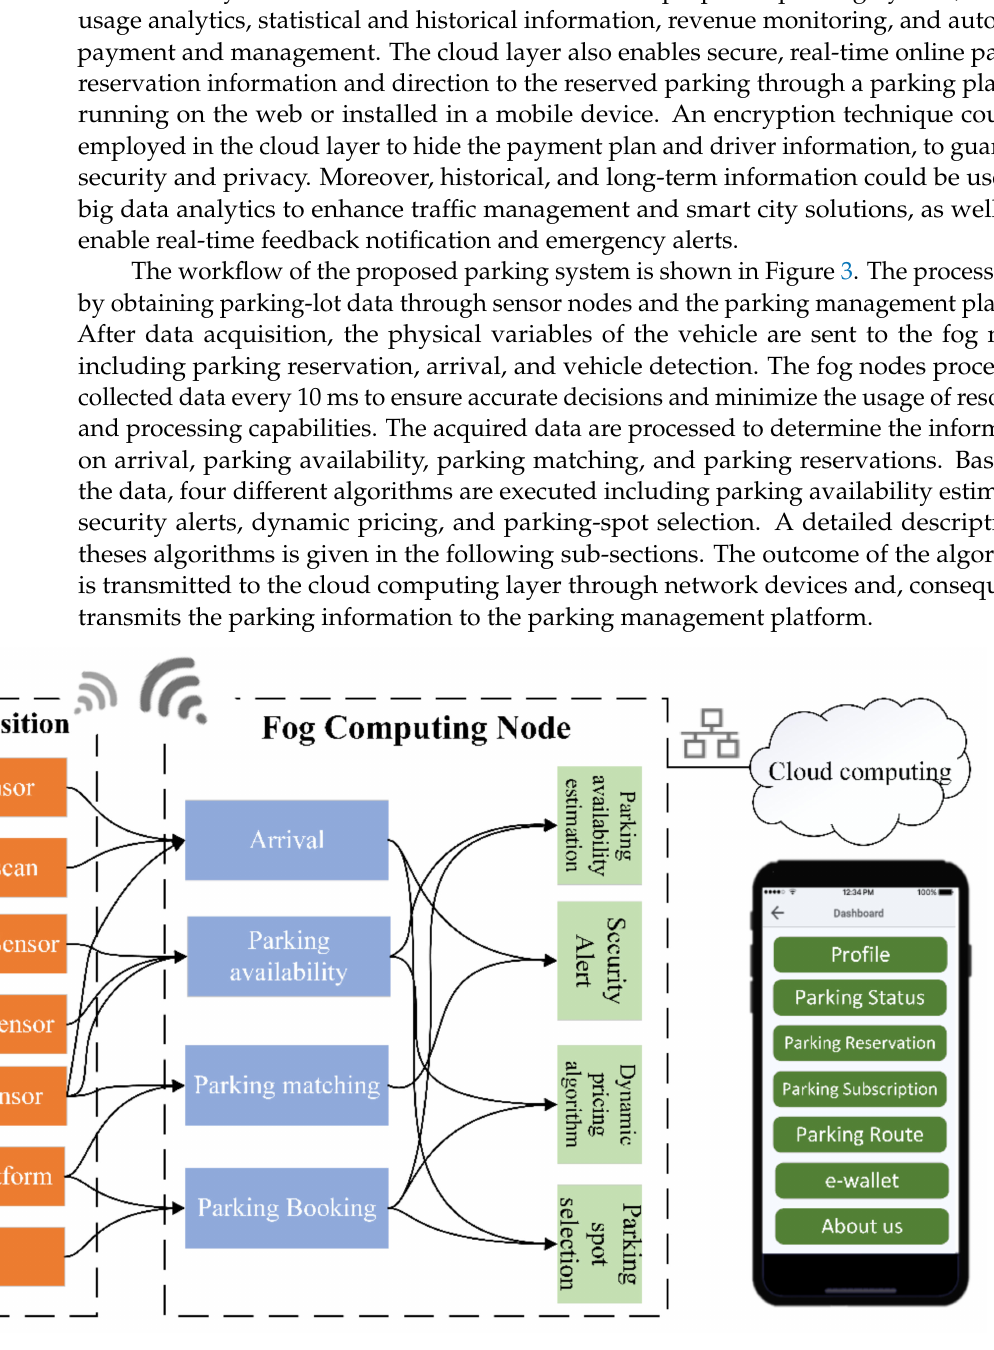
Figure 3. The operation of the smart parking